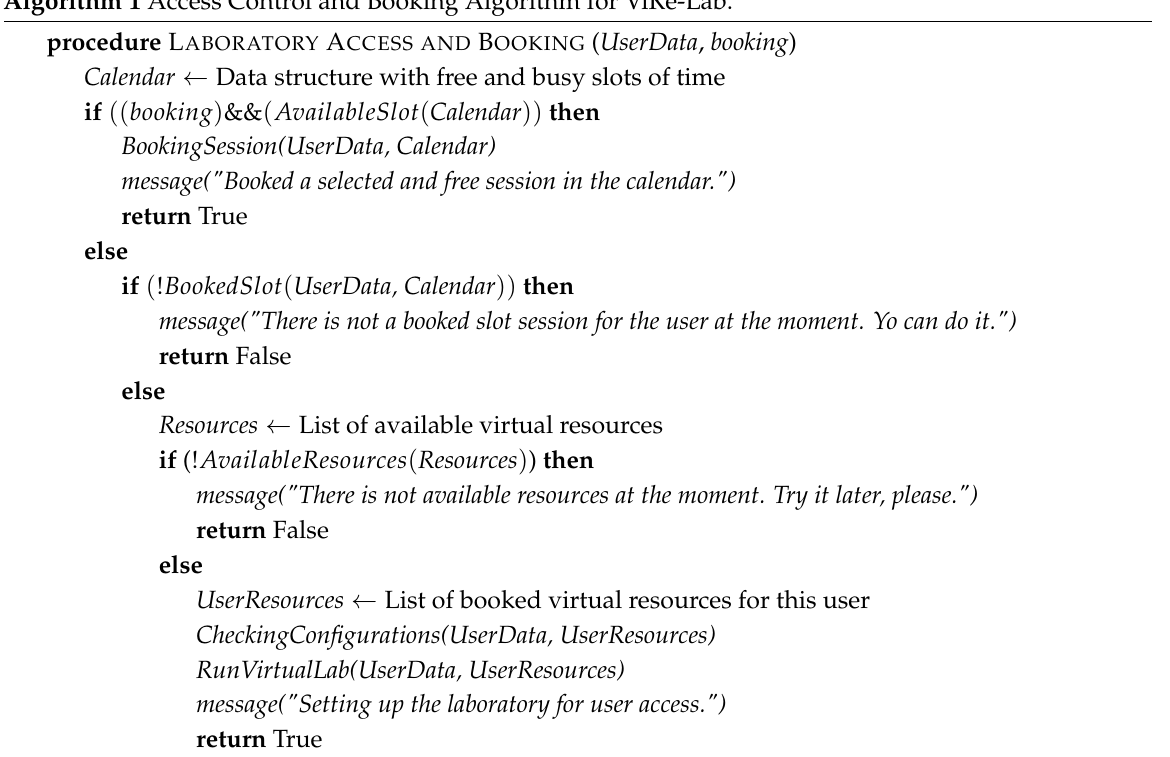
Algorithm 1 Access Control and Booking Algorithm for ViRe-Lab. procedure L ABORATORY A CCESS AND B OOKING ( UserData , booking